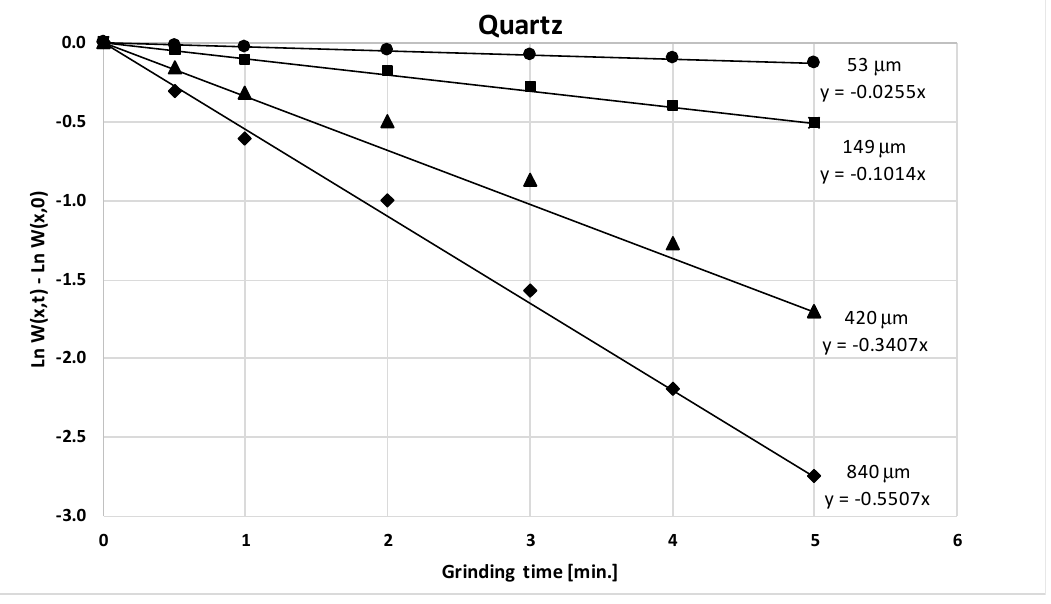
Figure 1. Determination of the kinetic constant, k , for a quartz sample; the lines are drawn from the starting point to the 5 min measurement.